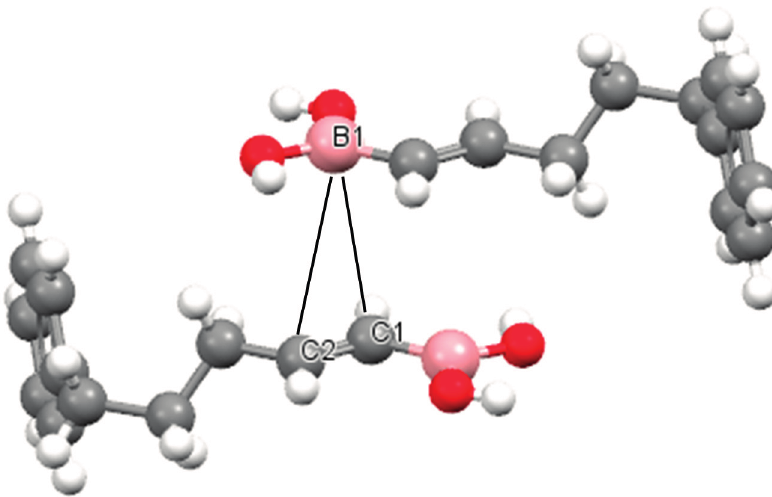
Figure 7. The fragment of the crystal structure of 5-phenylpent-1-en-1-yl)boronic acid, the boron-carbon contacts are shown (black solid lines) which correspond to the π -hole- π -electrons triel